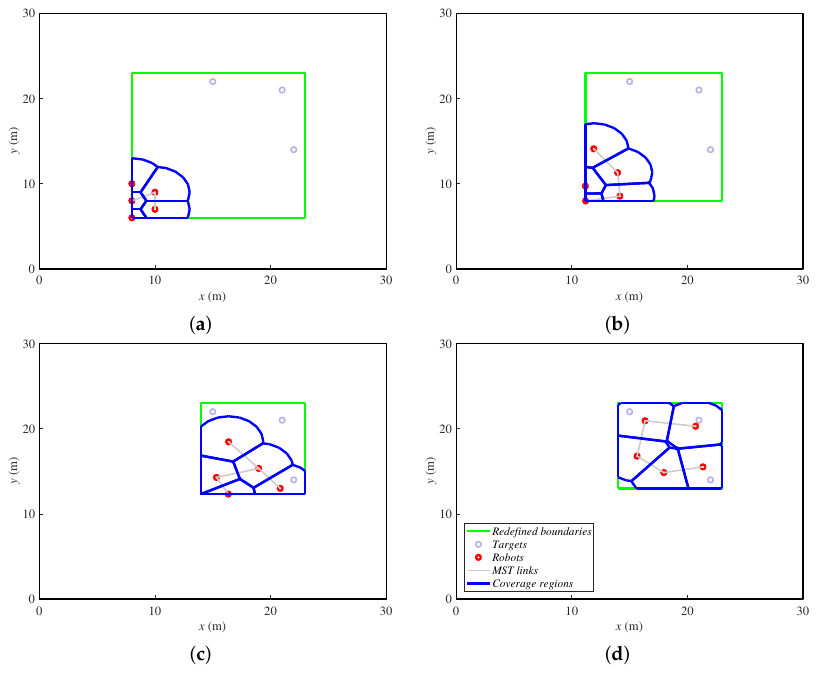
Figure 4. Ground robots’ positions in four steps (( a ) step 1, ( b ) step 6, ( c ) step 15 and ( d ) step 30 of 30) while covering three fixed targets delimited by fictitious boundaries.